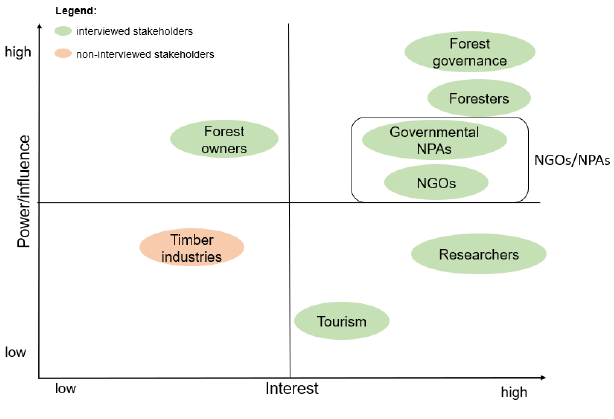
Fig. 1 . Power-interest grid showing the degree of interest and power of stakeholders on forest ecosystem services in monospecific and mixed forests in the Black Forest